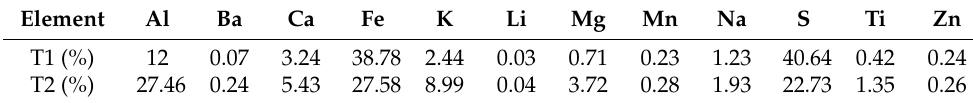
Table 2. Chemical composition of the solids content in tailings T1 and T2.